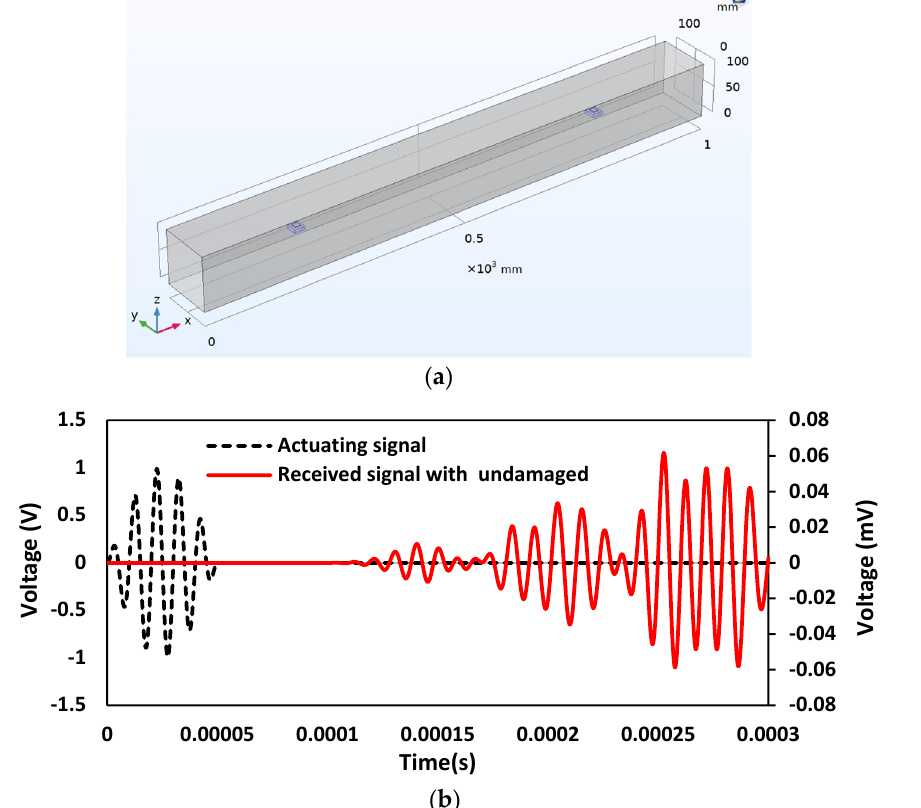
Figure 17. Concrete beam with embedded SSU: ( a ) Schematic 3-D model; ( b ) Response spectrum obtained from wave propagation measurements in the actuator–receiver mode.